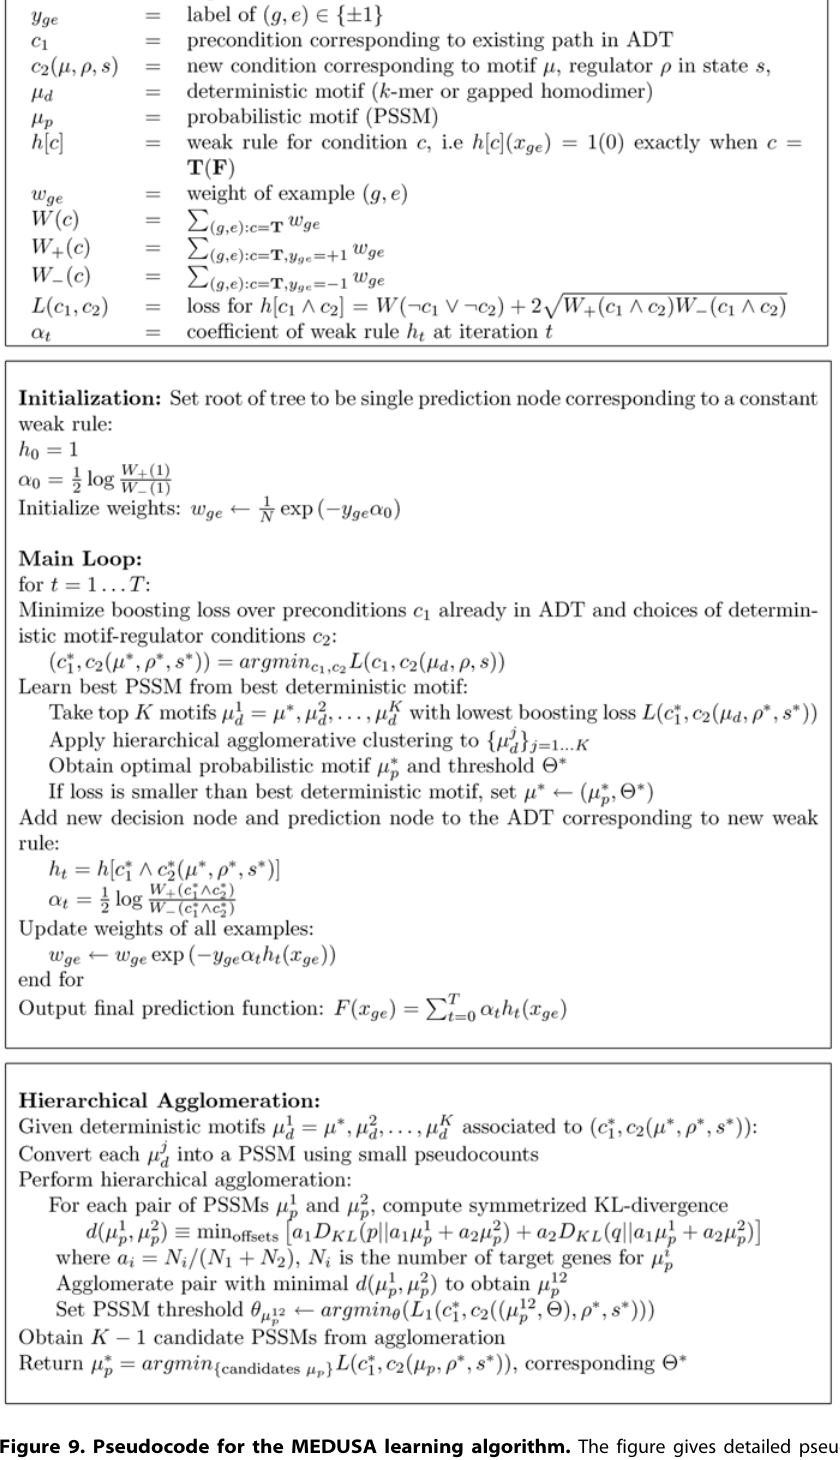
PLoS Computational Biology |